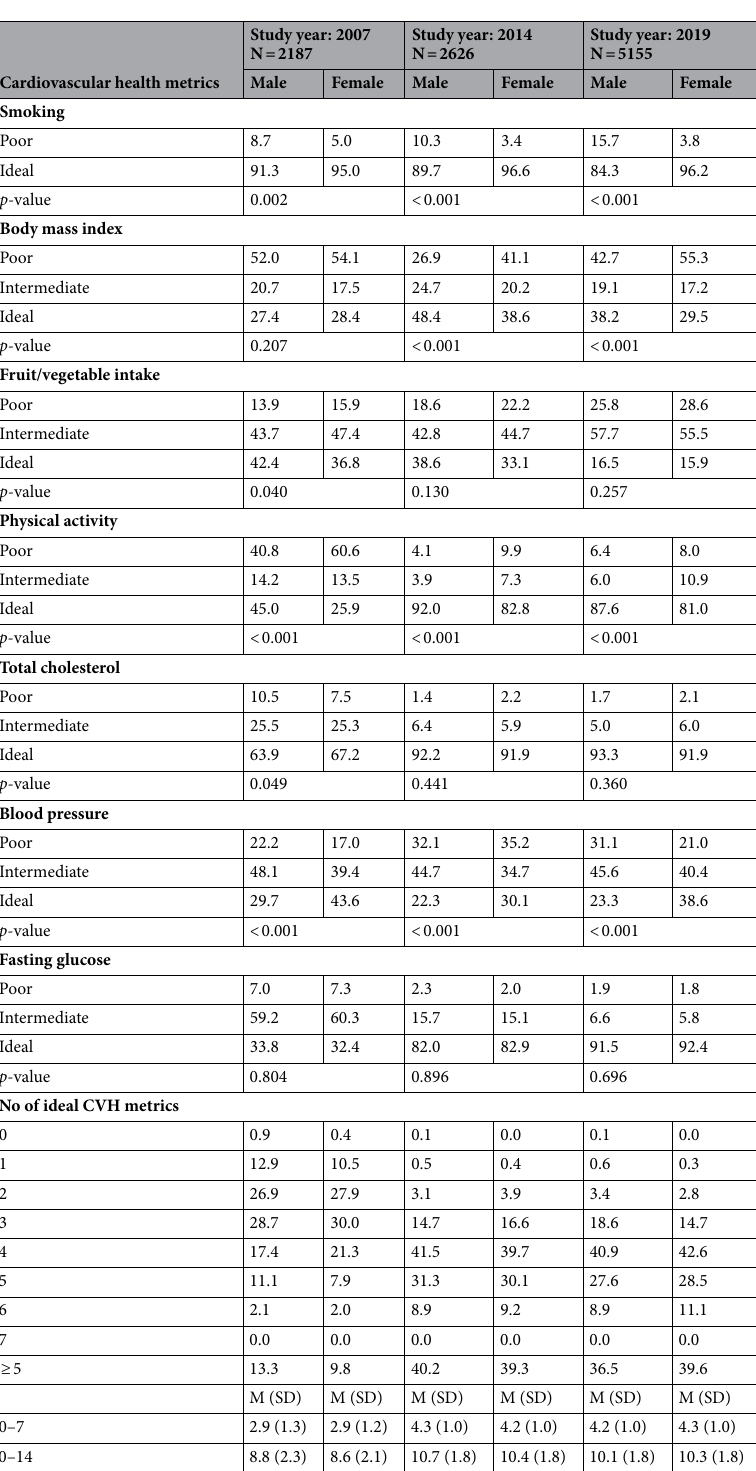
Table 4. Cardiovascular health (CVH) metrics distribution by sex and study year in